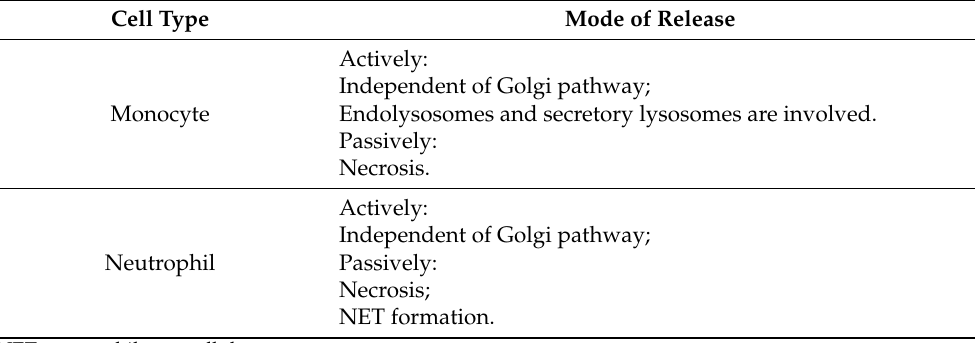
Table 1. Current concepts of calprotectin